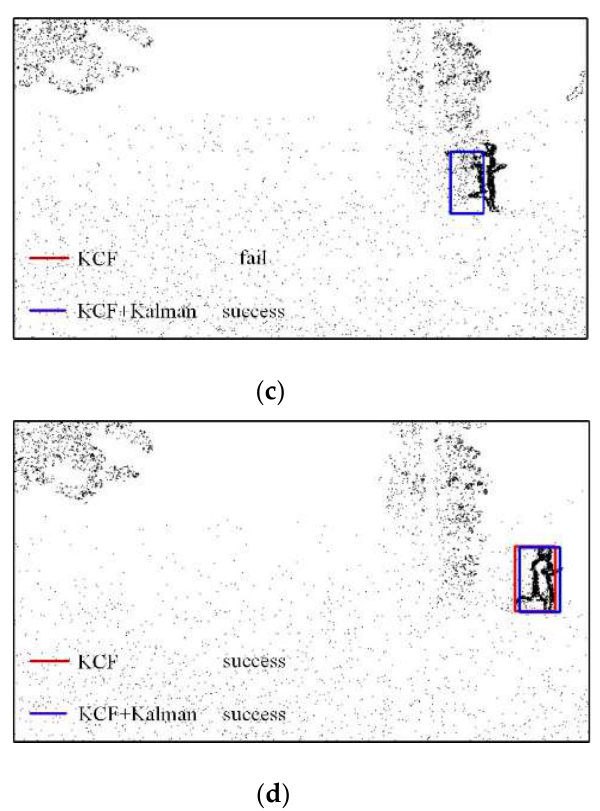
Figure 16. Comparison of object tracking results by KCF and improved KCF. ( a ) Frame 197, ( b ) Frame 205, ( c ) Frame 209, and ( d ) Frame215.